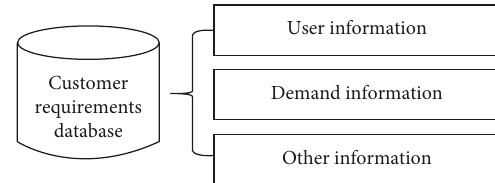
Figure 5: Customer demand database